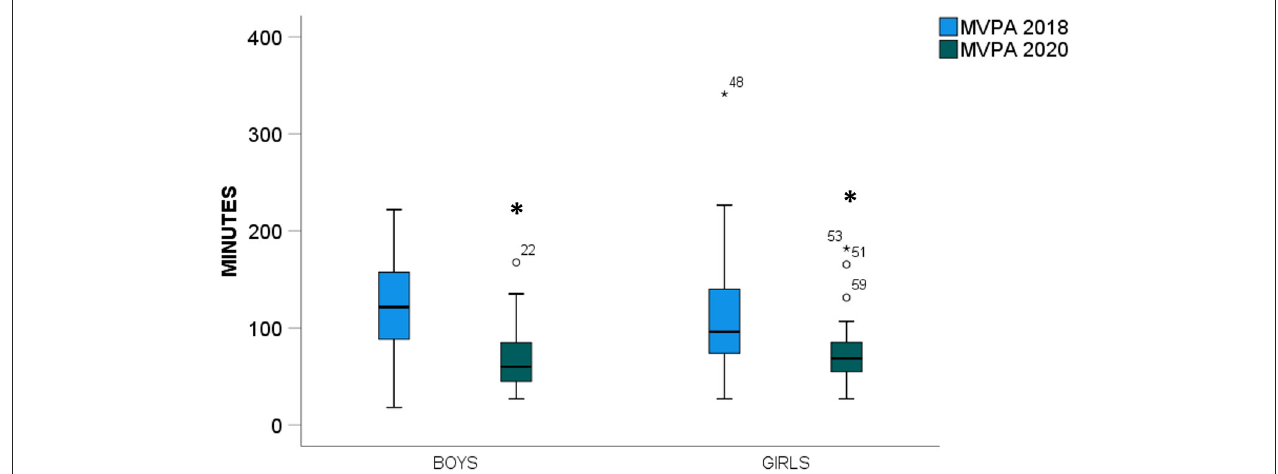
FIGURE 2 | Moderate-to-vigorous physical activity (MVPA) for boys and girls from October 2018 (blue) and April 2020, when COVID-19 movement restriction policies were in effect (green). *Indicates a significant main effect between time-points ( p <